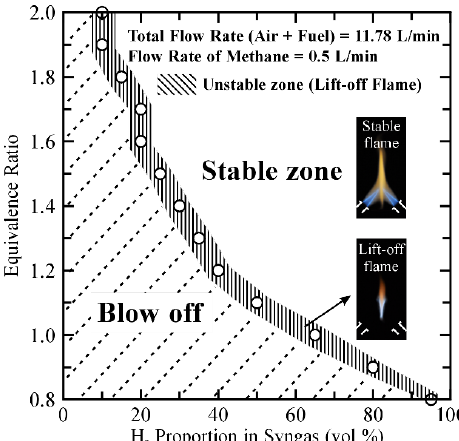
Figure 2. Operating range of a CH 4 /syngas/air premixed impinging flame at ϕ = 0.8 to 2.0 with a constant total volume flow rate Q total = 11.78 L/min and a constant methane volume flow rate Q methane = 0.5 L/min.